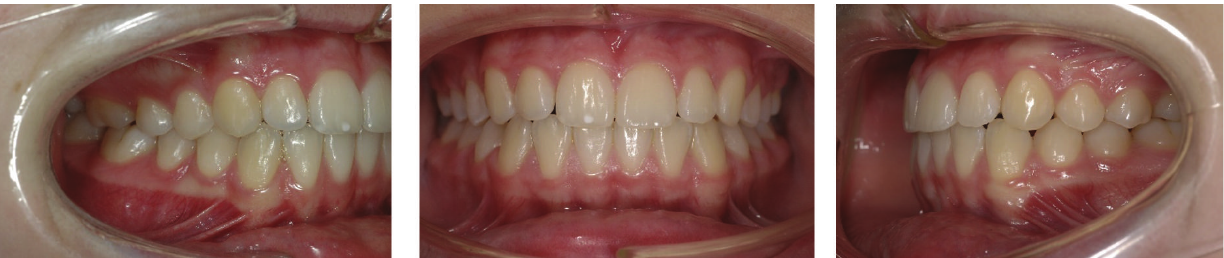
Figure 9: Four-year follow-up intraoral photographs.